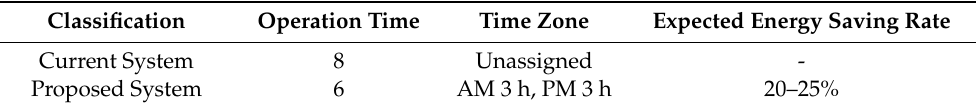
Table 8. Expected Benefits of the Proposed System.